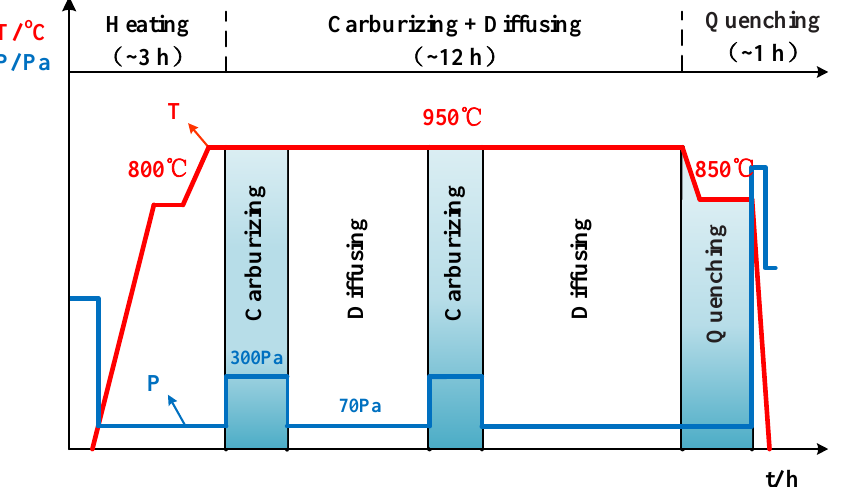
Figure 1. Schematic diagram of the vacuum low-pressure carburizing process.